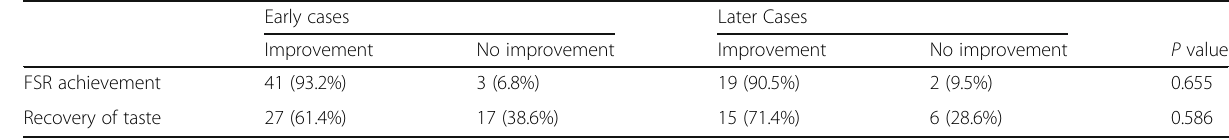
Table 3 Functional sensory and taste recovery in early and later cases at 24 months after surgery